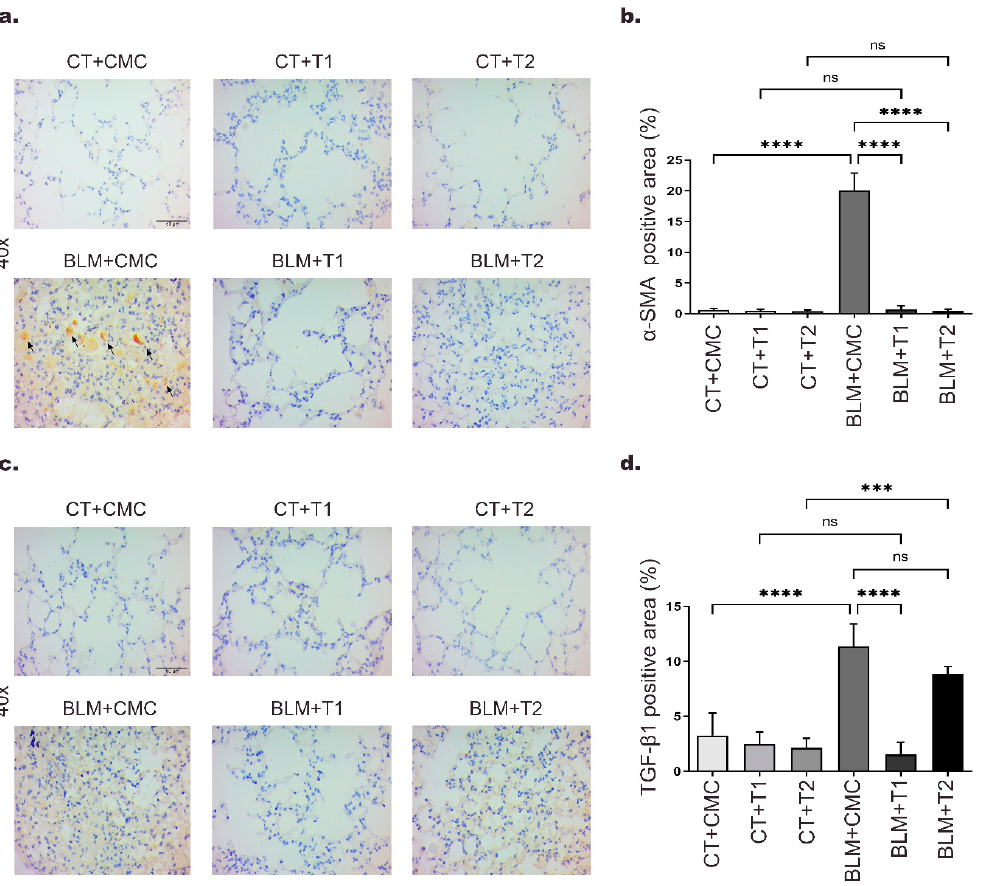
Figure 2. 3 ′ 5-DMBA reduces proteins related to pulmonary fibrosis expression in mice. Mice in BLM groups were instilled with an osmotic minipump loaded with BLM 100 U/kg. Mice in control groups (CT) have a sham instillation. On day 14, mice received either 3 ′ 5-DMBA or its vehicle intragastrically until they were euthanized on day 28. ( a , c ) Immunohistochemical staining for α -SMA and TGF- β 1 in lung tissue sections, respectively. Positive staining is shown in brown. Arrows show fibroblastic foci. ( b , d ) Bar graph showing immunohistochemical staining analysis for α -SMA and TGF- β 1 represented as the percentage of positive area made using ImageJ software. CT+CMC: control group, BLM+CMC: BLM-treated group, BLM+T1: BLM plus 3 ′ 5-DMBA-treated group at a dose of 6 mg/kg, and BLM+T2: BLM plus 3 ′ 5-DMBA-treated group at a dose of 10 mg/kg. Representative images were taken at 40× magnification. Scale bar = 50 μ m. Data are represented as the mean ± SD ( n = 4). Data were analyzed by one-way ANOVA followed by Tukey’s t -test for comparison between groups. For each graph, the asterisks above the horizontal lines indicate significant differences with respect to their control groups and differences between the two doses and the vehicle. *** p < 0.001, and **** p < 0.0001. BLM: bleomycin, CMC: carboxymethylcellulose (vehicle), and 3 ′ 5-DMBA: 3 ′ 5-dimaleamylbenzoic acid.